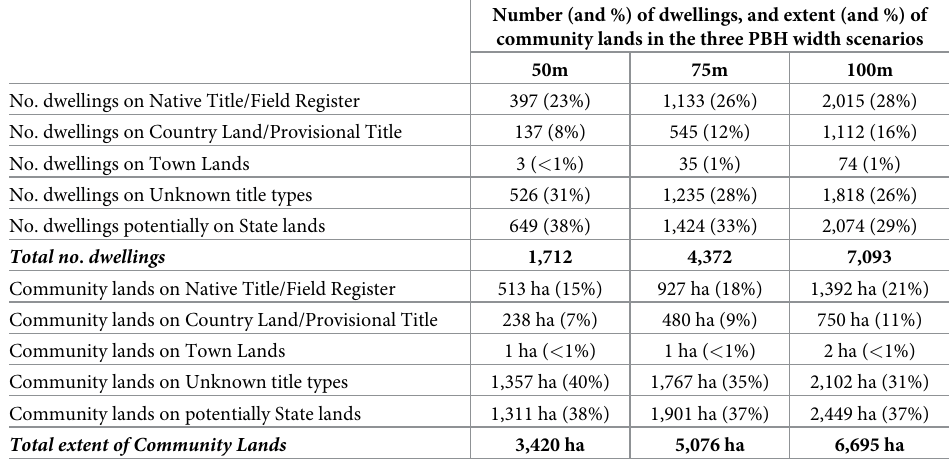
within Native Title/Field register titles; Country Land/Provisional Lease; Town Lands; titles that had been demarcated but had no code; and, possibly on State lands, for the three Pan Borneo Highway (PBH) width scenarios of 50m, 75m and 100m.